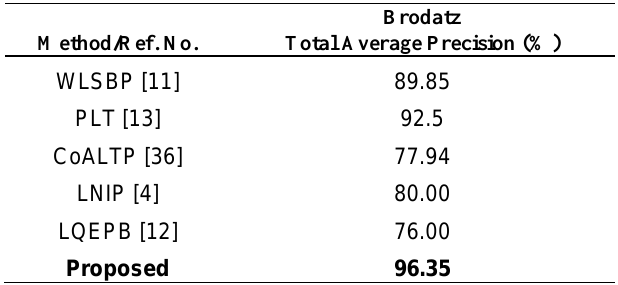
Table 3. Comparison of the proposed system with the